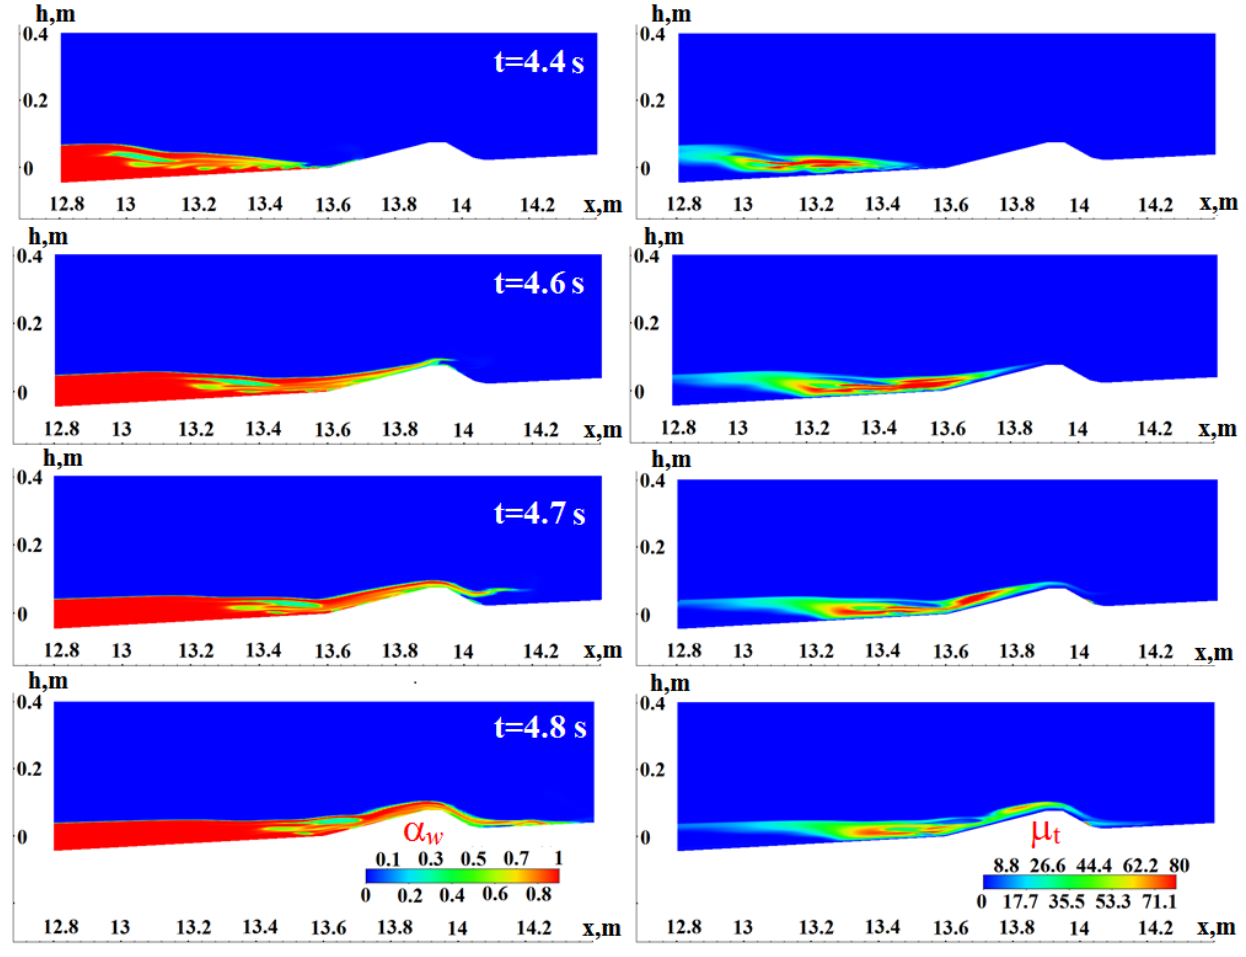
Figure 9. Time series of the free-surface position and turbulence viscosity for setup 3.